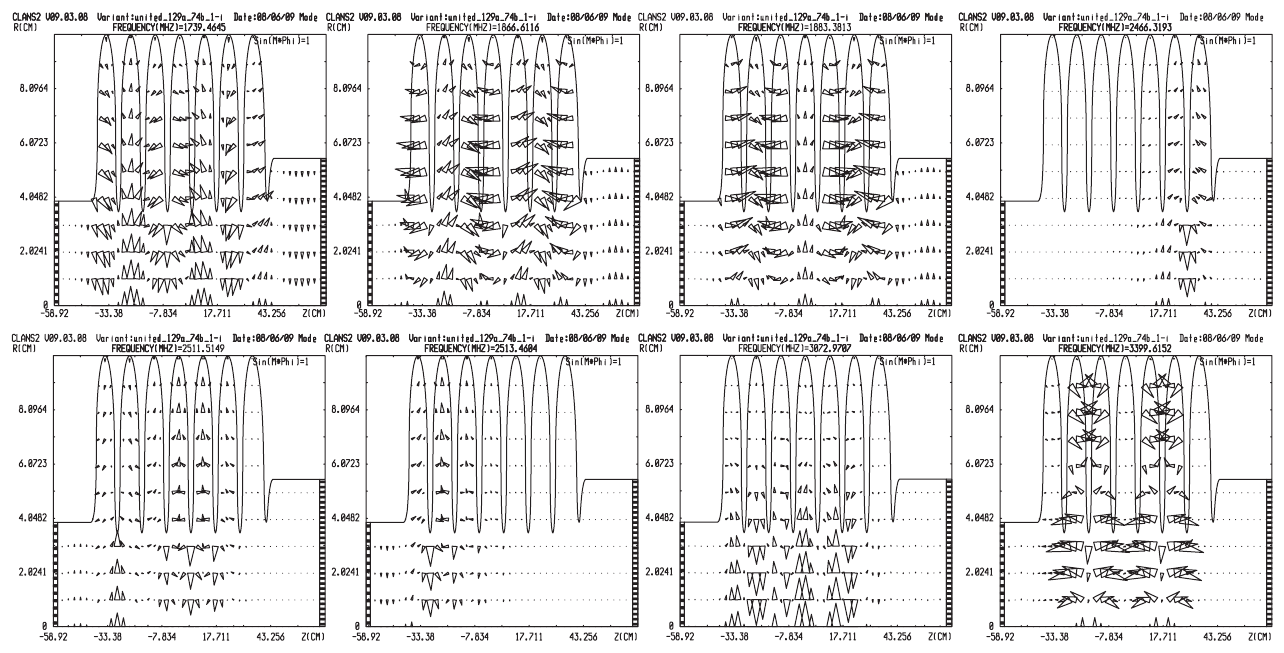
FIG. 24. Electric field of eight modes with biggest p